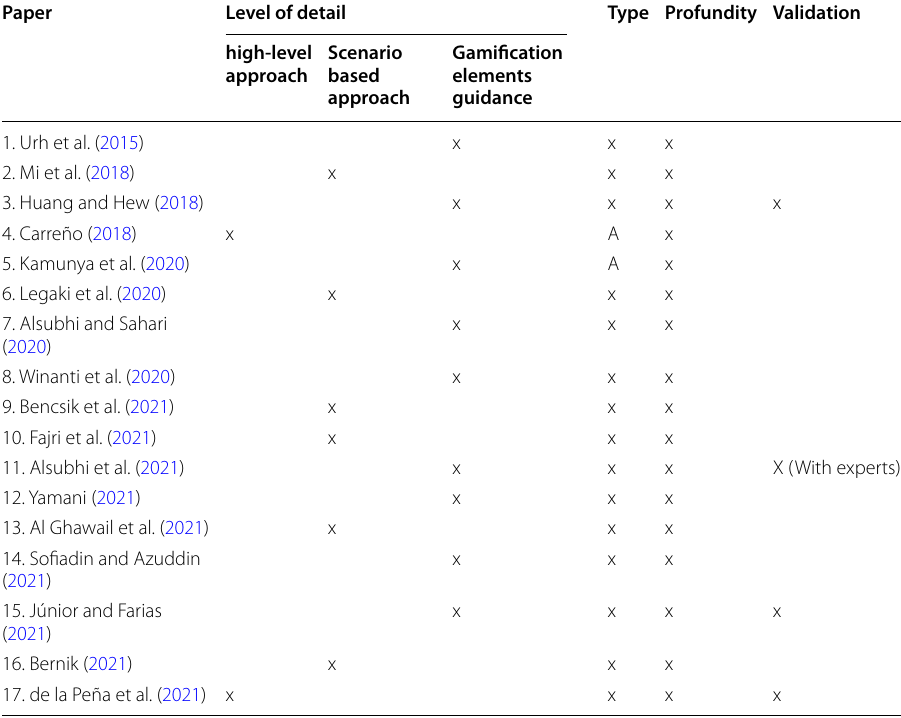
Table 4 Classification of gamification approaches (context of e-learning in higher education)